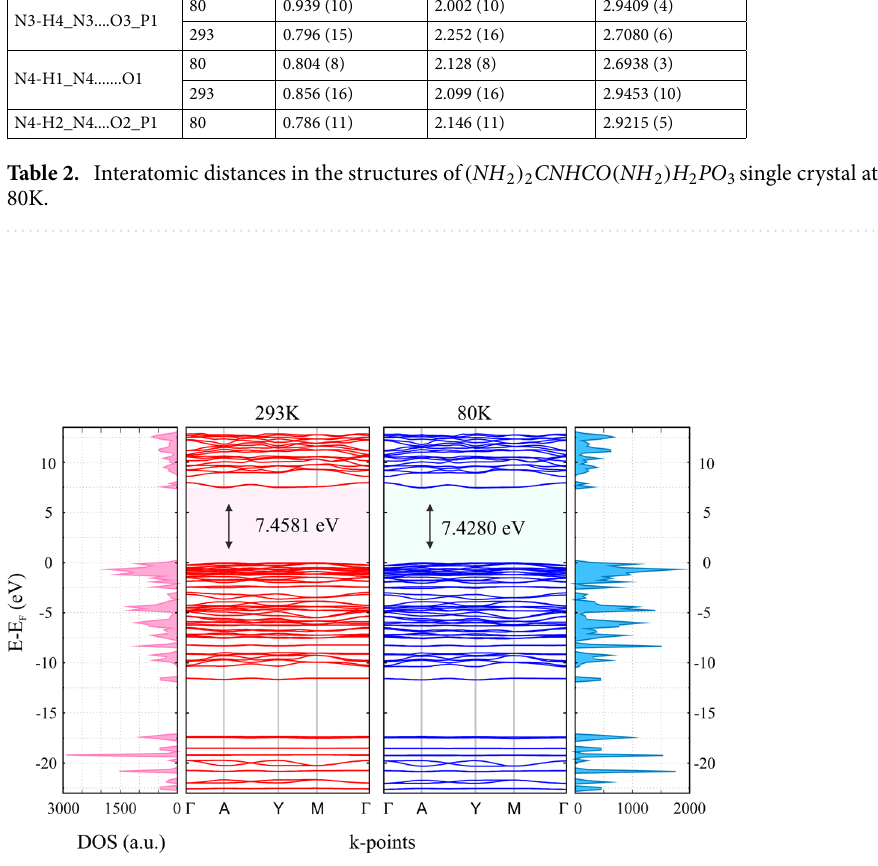
Figure 3. Calculated band structure and density of states (DOS) for GUHP. The energy of the band gap for both temperatures corresponds to the wavelength of the VUV spectral region, which is 166.24 nm (293K) and 166.91 nm